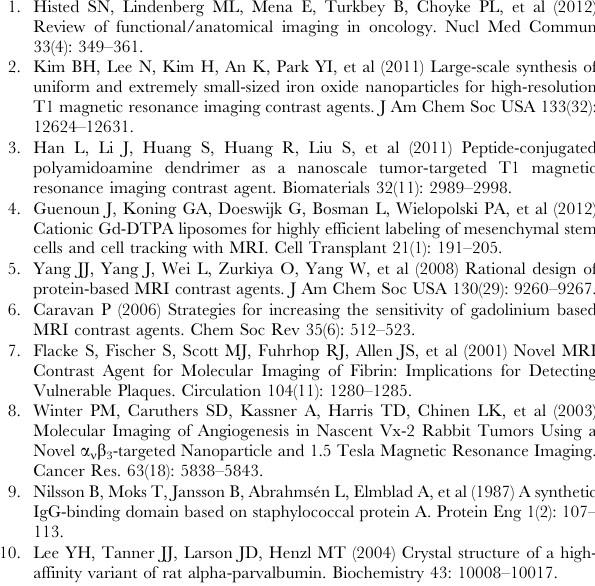
factor of 5–10 above relaxivities of clinically used small molecular weight contrast agents. (TIF) Figure S7 Stability of Zarvin in 50% FCS and 37 6 C over time. Aliquots were taken after distinct times (displayed in minutes) and investigated on degradation of Zarvin employing a Scha¨gger-Jagov gel. The lanes denoted ‘50% FCS’ serve as a control and do not contain Zarvin. The lanes denoted ‘‘Z/P’’ serve as a control as well and contain Zarvin only. M: Mark 12. (TIF) Figure S8 Melting curves of Zarvin and single domains. CD spectra at 225 nm were recorded while temperature was raised from 15 to 95 u C. The thermal stability of Zarvin (blue), Zarvin:(Gd 3 + ) 2 (black) and the single domains S55D/E59D alpha- Parvalbumin (green) and Z domain (red) could be characterized by extracting melting points from the first derivative of the melting curves. (TIF) Table S1 Data collection and refinement statistics. Calculated and measured secondary structure elements from DSSP and CD spectroscopy,